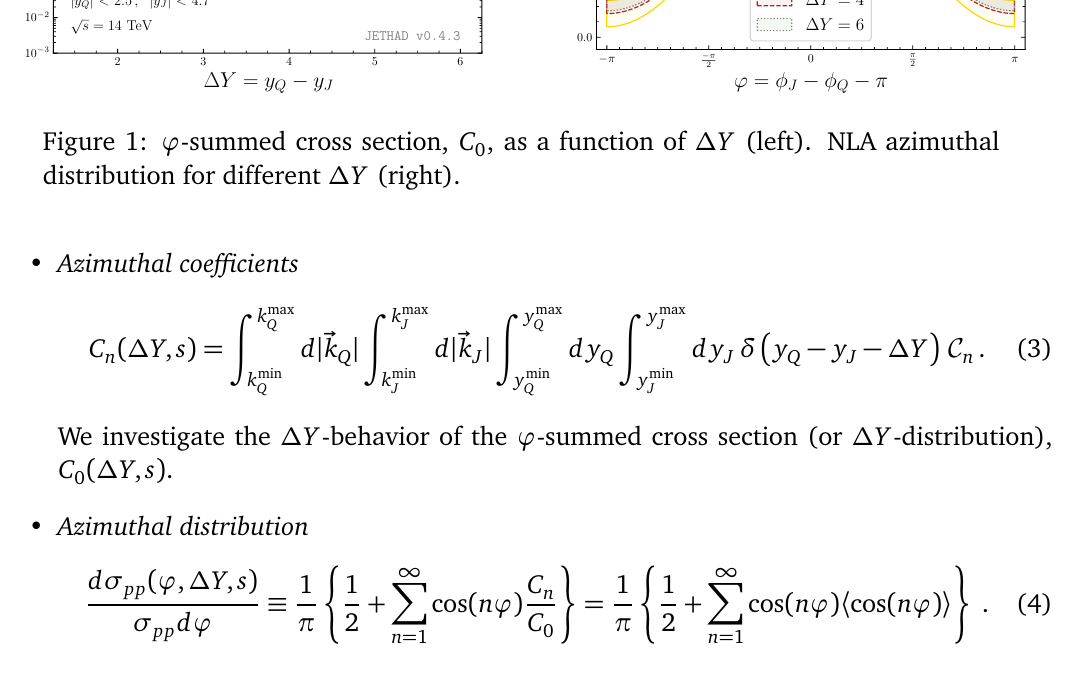
, as a function of ∆ Y (left). NLA azimuthal 0